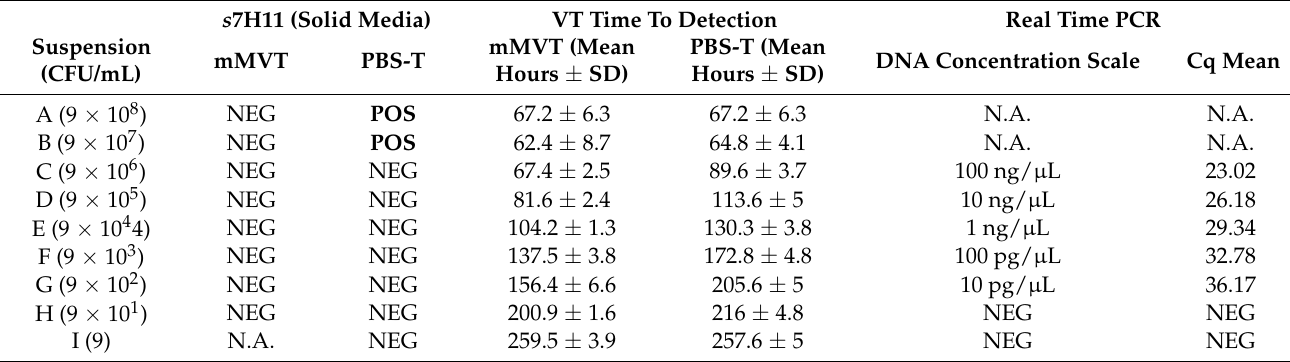
Table 1. Results for the setting and validation of bacteriological and molecular methods of M. chimaera detection. mMVT denotes modified Middlebrook 7H9 Broth; PBS-T phosphate-buffered saline added with 0.5% Tween 20; VT VersaTREK™ system; POS positive; NEG negative; TTD time to detection; SD standard deviation; N.A. not available. s 7H11 (Solid